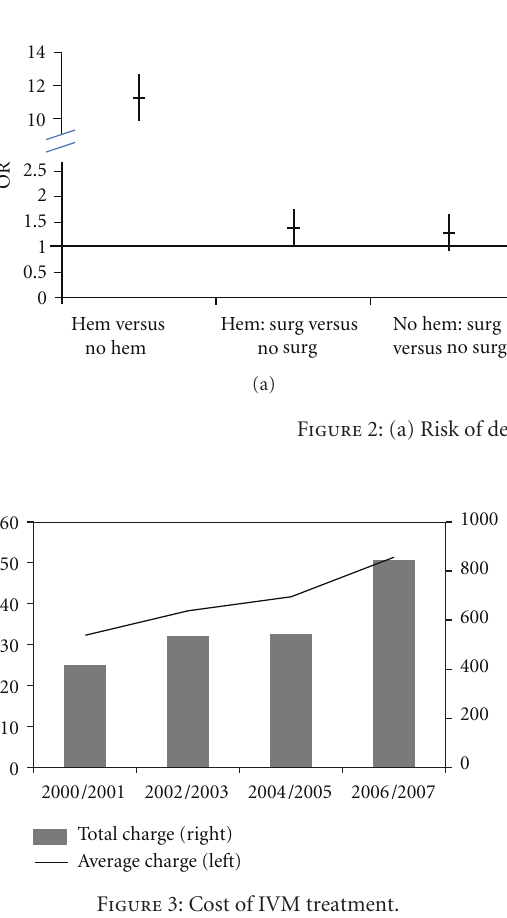
Figure 3: Cost of IVM treatment.